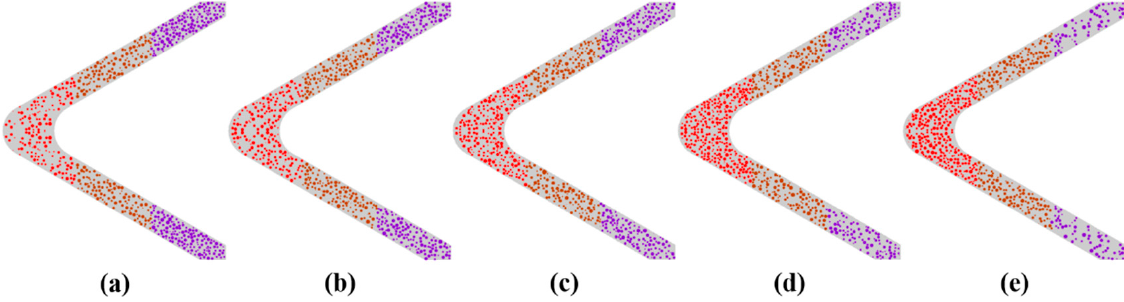
Figure 17. Liner models of different particle distributions: ( a ) ρ liner = 0.5, ( b ) ρ liner = 0.75, ( c ) ρ liner = 1, ( d ) ρ liner = 1.5 and ( e ) ρ liner = 2. Note: The material colors are the same as in Figure 15. The aluminum mass ratio in HSSJ for different liner granule distributions are shown